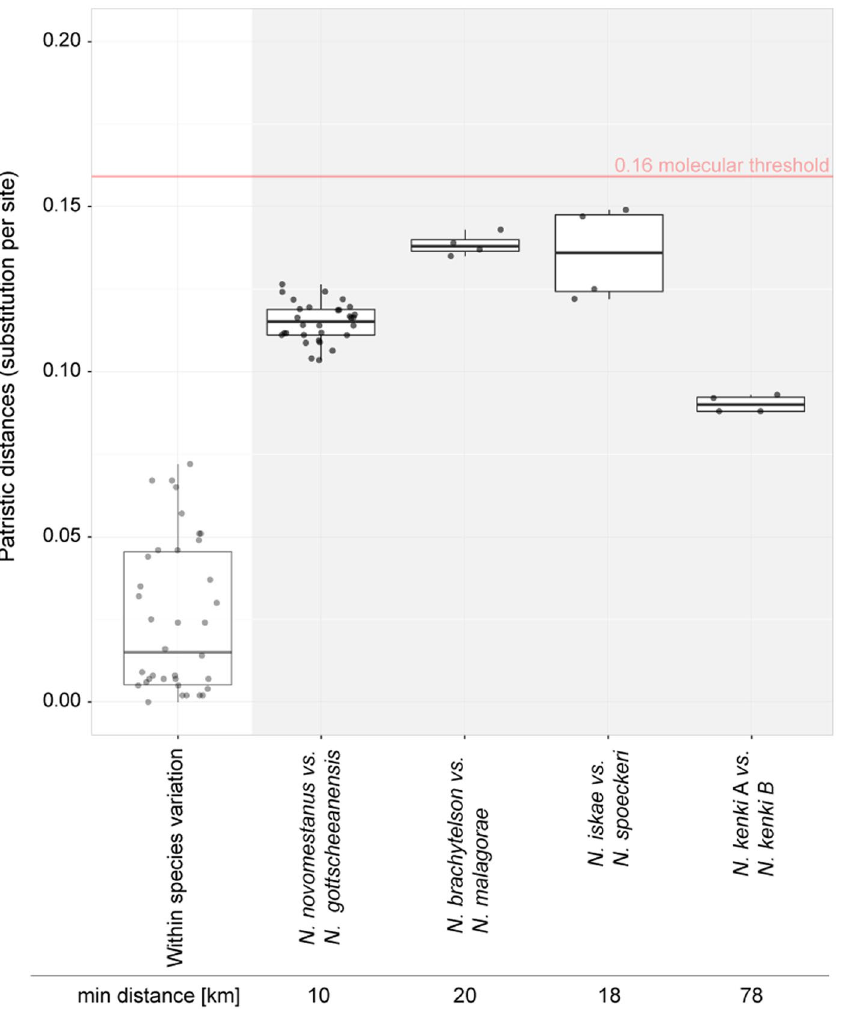
Figure 3. Patristic genetic distances based on COI gene sequences. Only those putative species are shown that diverged less than the proposed threshold of 16%. Within-species distances, pooled for all eight putative species (left boxplot), are substantially lower than between-species distances calculated for all four pairs of species (right boxplots). Three pairs are geographically close (nearest distances among sampling sites indicated at the bottom), whereas the least divergent pair of hypothetical species is geographically